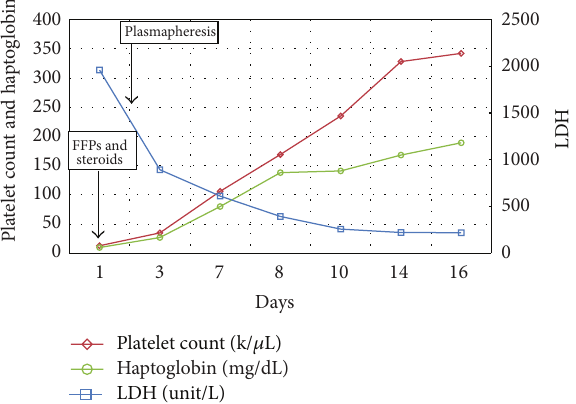
Figure 2: Platelet count, haptoglobin, and LDH over the course of